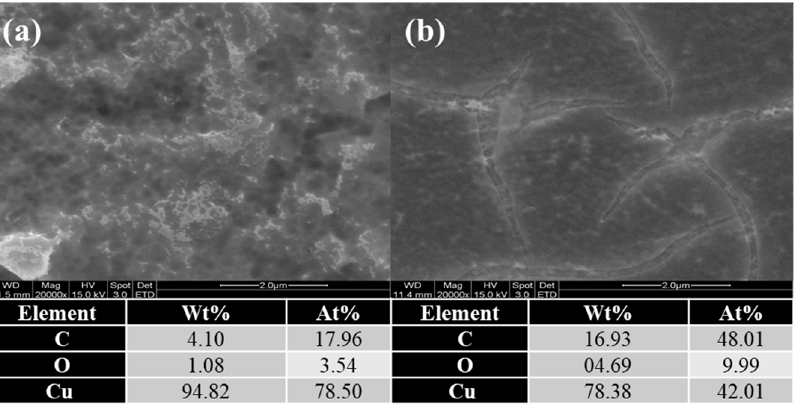
Figure 5. SEM images and EDS analysis results of etched samples: ( a ) AF-CMP and ( b ) EAF-CMP.